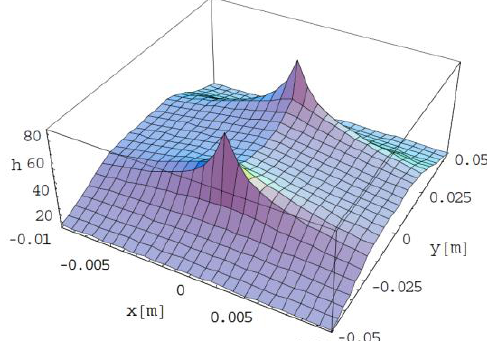
Fig. 3. Spatial distribution of the magnetic field modulus on the plane z = l /2 of the ribbon busduct of finite length; l = 1 m, b = 0.05 m.